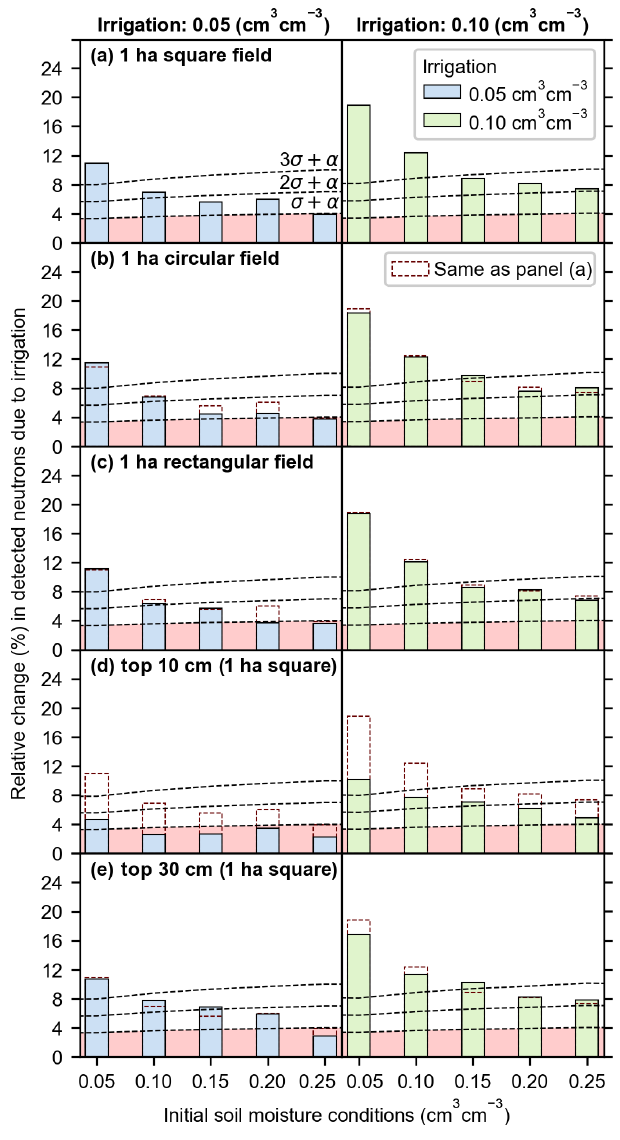
Figure 10. CRNSs’ chance of detecting irrigation events of 0.05 and 0.10cm 3 cm − 3 (blue and green bars, respectively) in (a) a 1ha squared field, (b) a 1ha circular field, and (c) a 1ha rectangular field and for SM variations that affect only the top (d) 10 and (e) 30cm of soil for a 1ha squared field. The bars show the relative change in detected neutrons induced by the irrigation event, while the dashed black lines show the prescribed detection certainty thresholds. In panels (b–e) , the dashed red bars indicate the results of panel (a) (1ha squared field). The red area below the σ + α threshold indicates uncertain